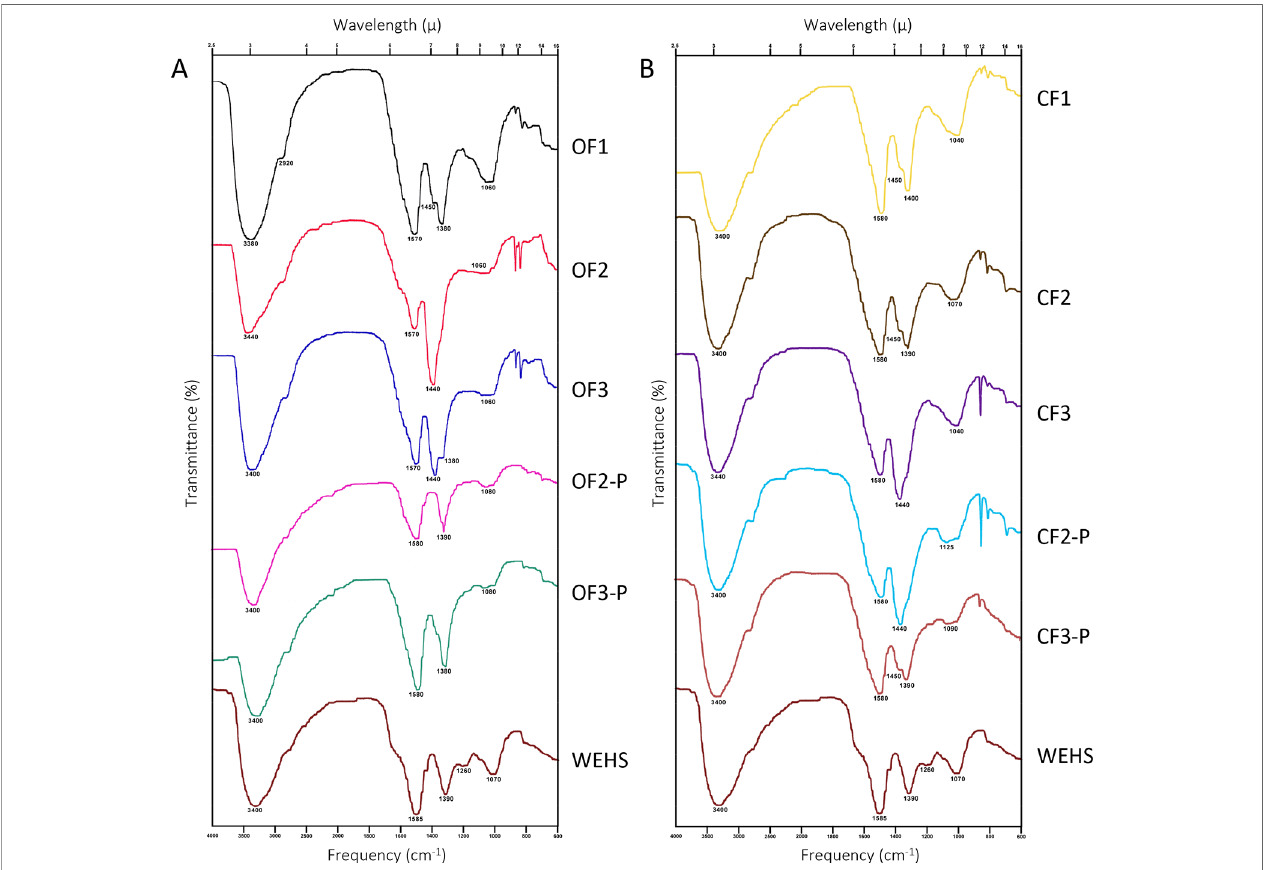
FIGURE 7 | FTIR spectra of dissolved humic substances (DHS) fractions isolated from organic farming (OF) soils (A) and from conventional farming (CF) soils (B) . OF1 and CF1 were sampled in November; OF2, OF-P2, CF2, and CF-P2 were sampled in April; OF3, OF-P3, CF3, and CF-P3 were sampled in June. OF1, OF2, OF3 and CF1, CF2, CF3 refer to leachates collected from bare soil columns. OF-P2, OF-P3 and CF-P2, CF-P3 refer to leachates collected from planted soil